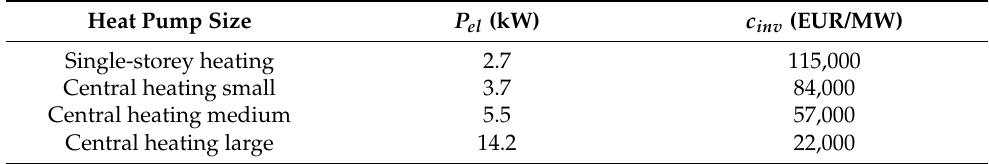
Table 2. Investment costs for the flexibilisation of different heat pump size classes [25].